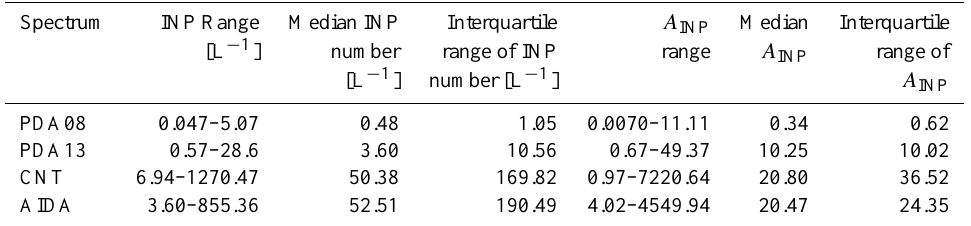
Figure 2. Measurement–model comparison of probability distributions in ice crystal number concentrations. Data distributions come from the Video Ice Particle Sampler (VIPS) and the two-dimensional stereo (2DS) probe during April 2011 of the MACPEX campaign and the Forward-Scattering Spectrometer (FSSP) during January 2010 of the SPARTICUS campaigns. Only measurements from the 10–20µm bin of the VIPS; the 5–15µm bin of the 2DS; and the 0.89, 1.90, 3.80, 5.85, 8.30, 11.45, 14.25, 17.15 and 20.45µm-centered bins of the 2DS are used, as approximations to the newly nucleated ice crystal number. Measurements are also filtered for altitudes of 232 ± 20hPa and for uniformity, lasting at least 45s. Distributions of simulation output, i.e. of the annually averaged output nucleated ice crystal number, N i , as in Fig. 3, are shown using the (a) PDA08, (b) PDA13, (c) CNT and (d) AIDA nucleation spectra. Different independent axes are used in panels (c) and (d) . Table 2. Range of predicted ice-nucleating particle numbers and abundances for different nucleation